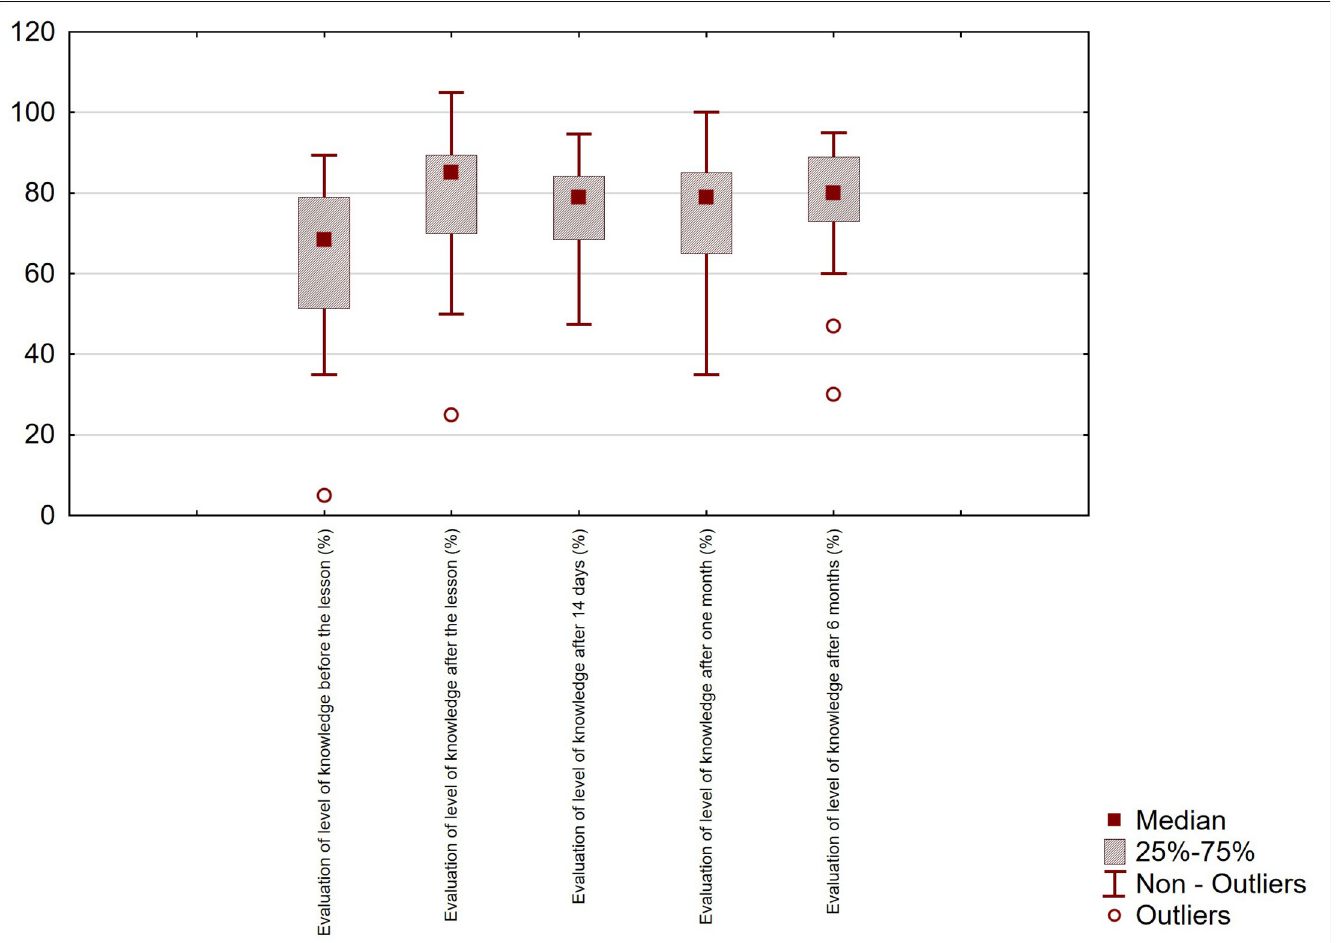
Fig 3. The level and distribution of knowledge of students who participated in school education in